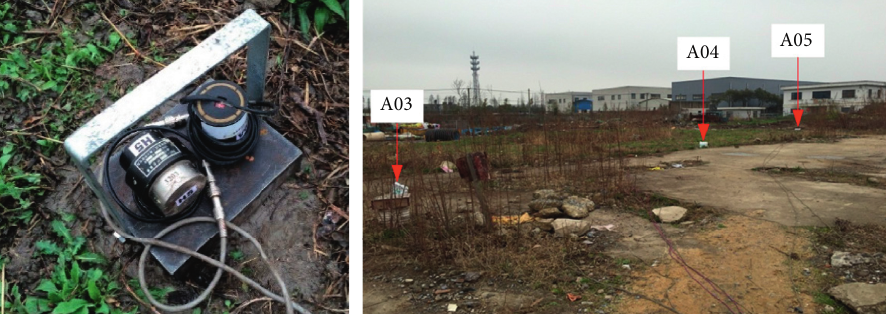
Figure 8: Accelerometers installed on the ground